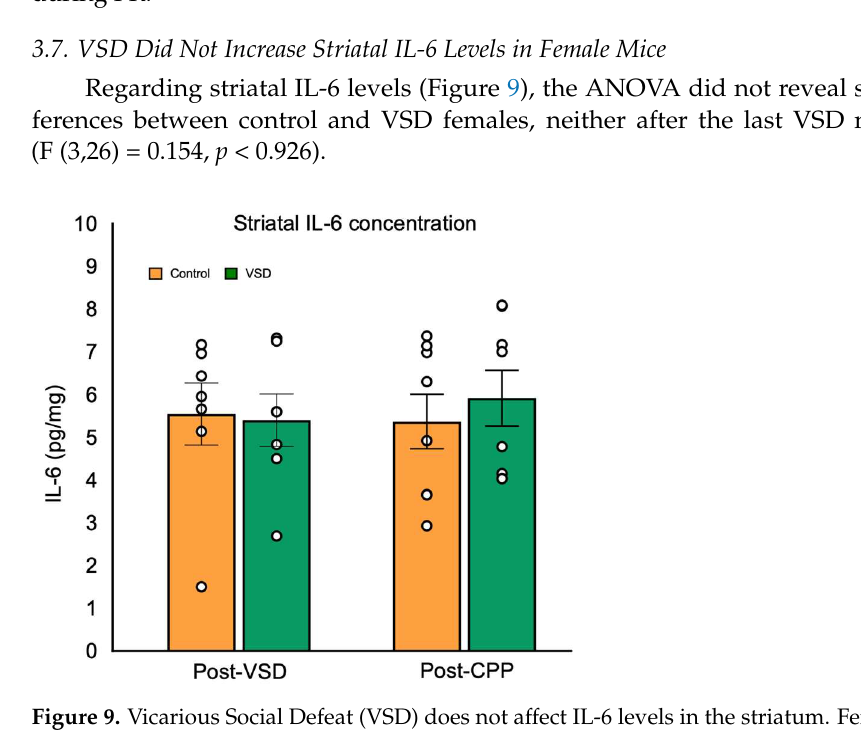
Figure 8. ( a ) Effect of Vicarious Social Defeat (VSD) on ethanol intake during Drinking in the Dark (DID). The dots represent means and the vertical lines ± SEM of the g/kg of ethanol at 20% con- sumed. ( b ) Oral ethanol Self-Administration (SA). The dots represent means and the vertical lines ± SEM of the volume of 20% ethanol consumption during FR1 (in g/kg) and the stress effect (F(1,24) = 6.928; p< 0.015). ** p< 0.01, significant difference in ethanol consumption with respect to the control group. ( c ) The number of active responses. ( d ) The columns represent means and the vertical lines ± SEM of breaking point values and the volume of 20% ethanol consumption (in g/kg) obtained during PR (control group, n = 14; VSD group, n = 12).